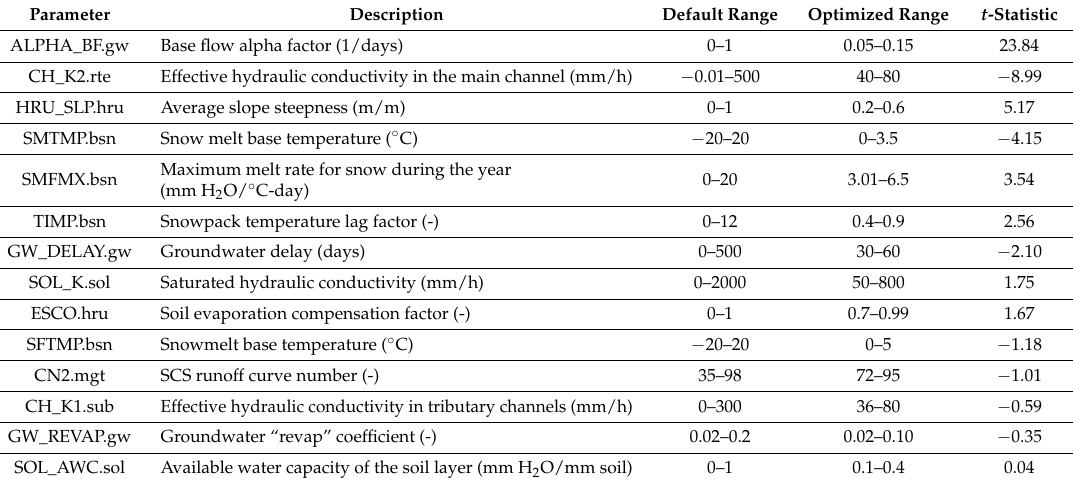
Table 3. Descriptions of the sensitive parameters and their degrees of